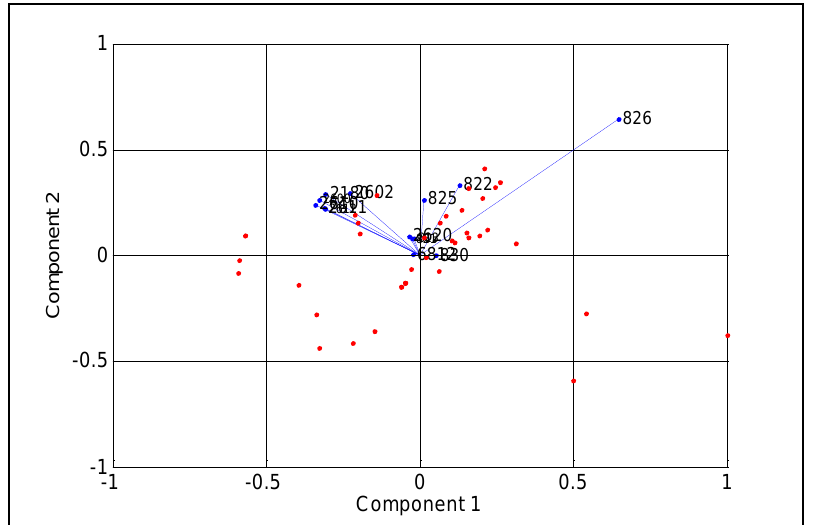
Figure 13. The loading values for analysis on pasteurized and UHT